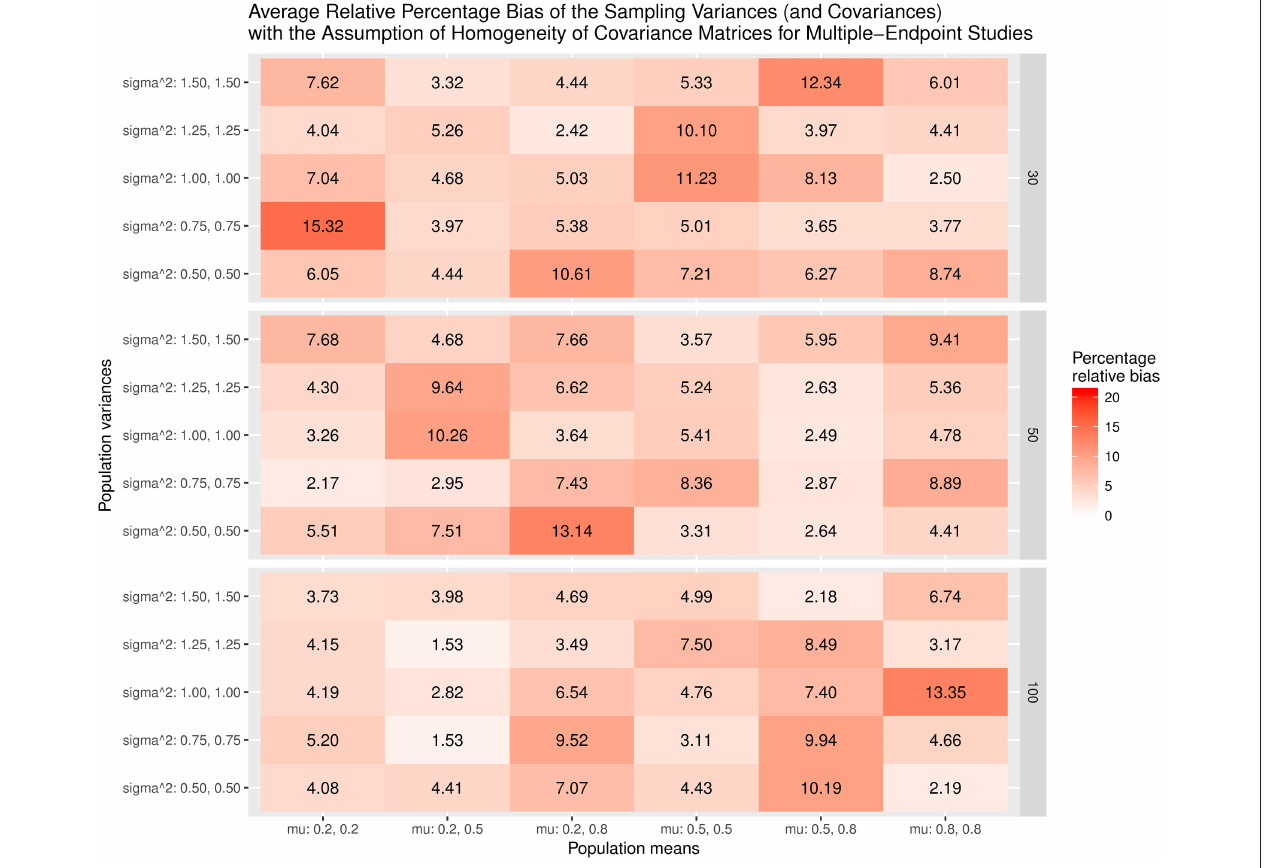
Frontiers in Psychology |